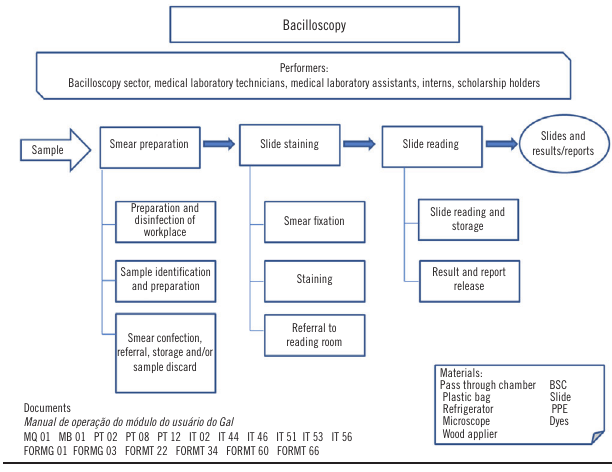
figurE 4 – Flow chart of bacilloscopy assay BSC: biological safety cabinet; PPE: personal protection